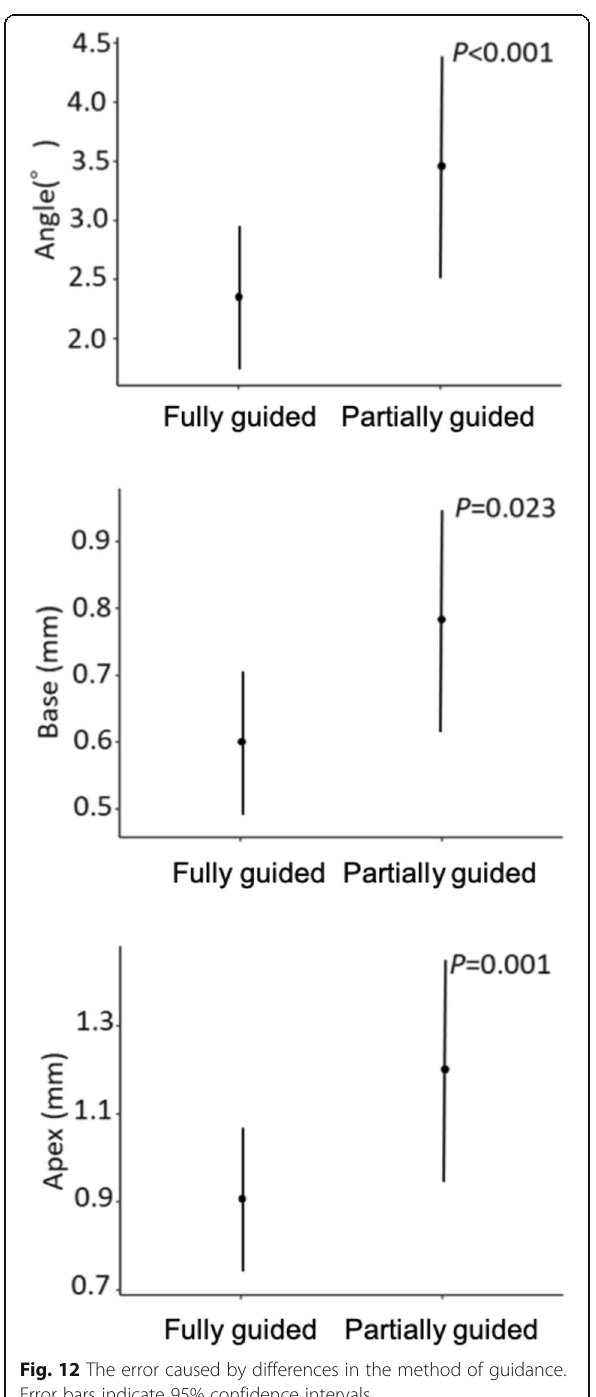
Fig. 12 The error caused by differences in the method of guidance. Error bars indicate 95% confidence intervals